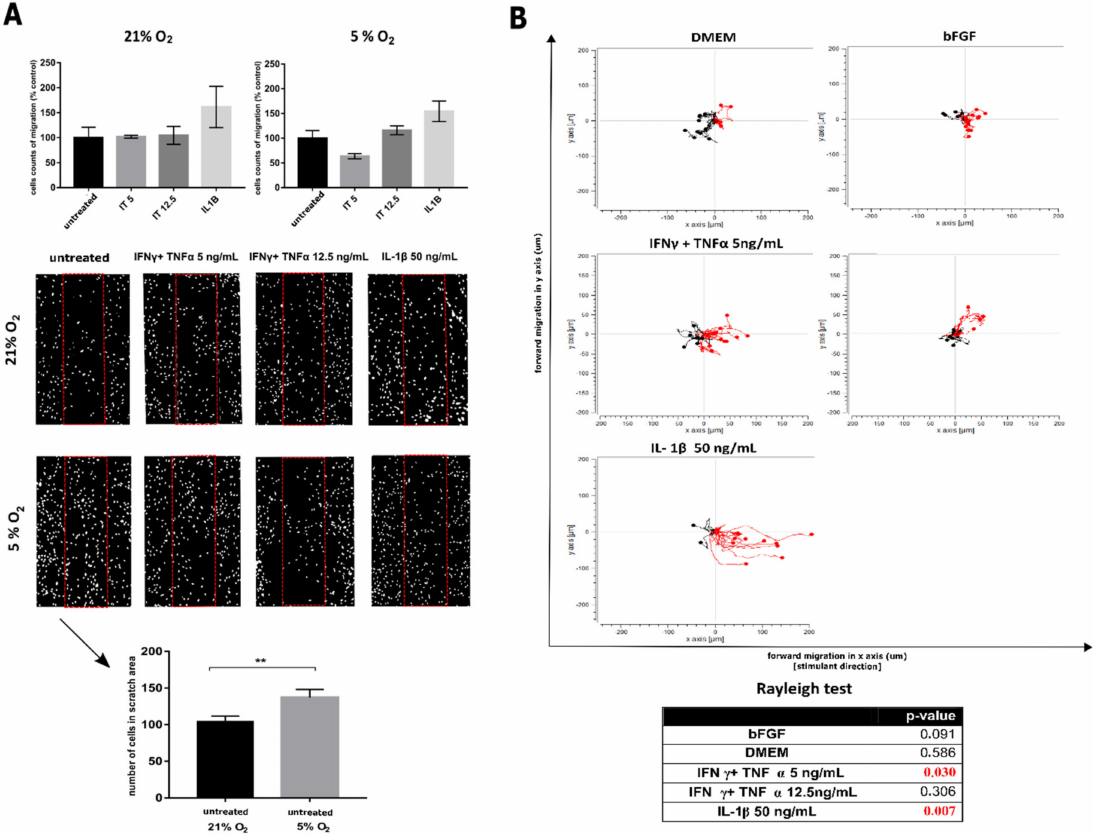
Figure 6. Migratory activity of WJ-MSCs. ( A )—scratch assay analysis. IL-1 β -treated cells at a concentration of 50 ng/mL displayed the greatest capacity for migration in culture under both oxygen concentrations. Under the conditions of 5% O 2 , control cells migrated faster than that cultured in 21% O 2 . The results are mean values (one-way ANOVA) from 3 independent experiments in min. 3 replicates ± SD, ** p < 0.01. ( B )—chemotaxis. WJ-MSCs did not exhibit motility in the control environment. However, slightly increased migration towards the bFGF attractant was observed. Presence of the proinflammatory cytokines in the environment was the strongest factor enhncing migration (red line—movement towards cytokines). The strongest effect was observed when IL-1 β was added to the medium. Table with results Rayleigh test. Statistically significant results are marked in red. In IFN γ and TNF α in concentration 5 ng/mL and IL-1 β -treated cells distribution inhomogeneous. The results are min 20 cells from 3 different umbilical